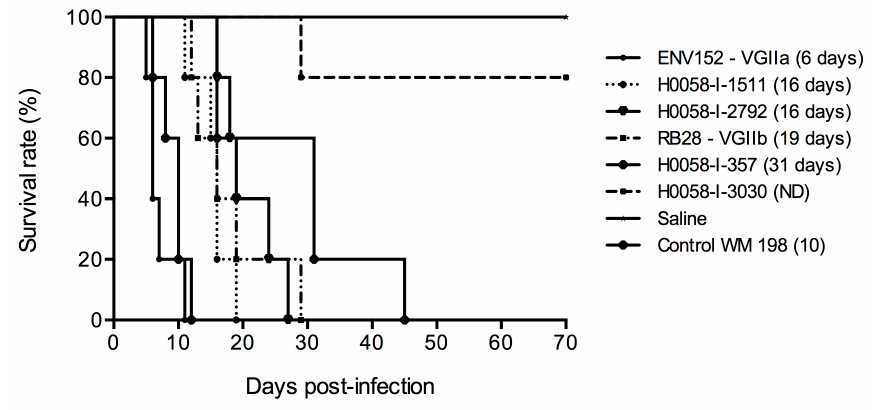
Figure 4. In vivo survival curves. BALB / c mice were inoculated with Cryptococcus gattii VGII isolates from Cucuta and Vancouver Island. Median survival time in days is indicated in brackets.